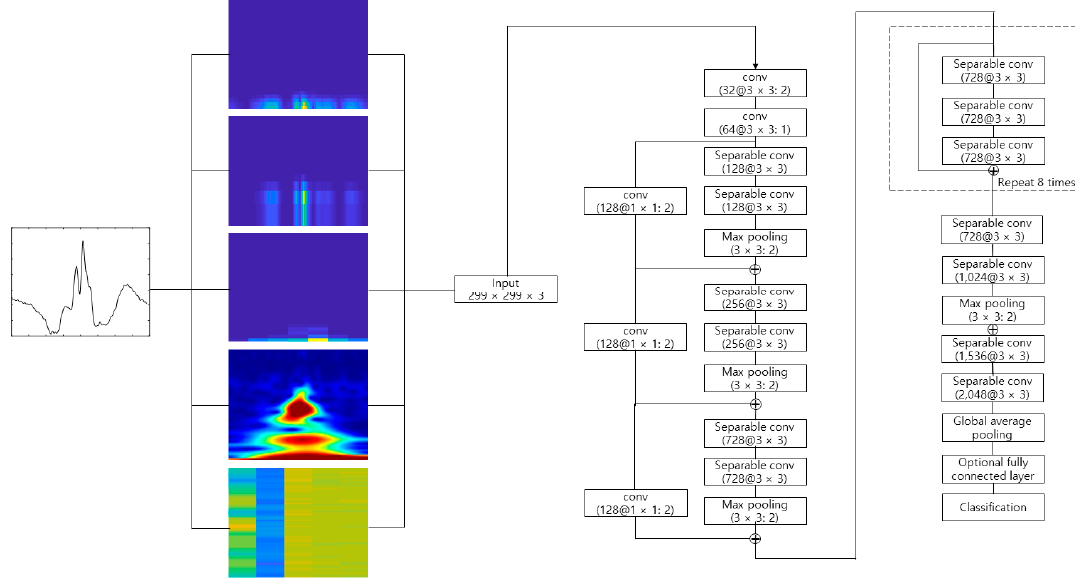
Figure 4. Structure of Xception with the time-frequency representations as inputs.